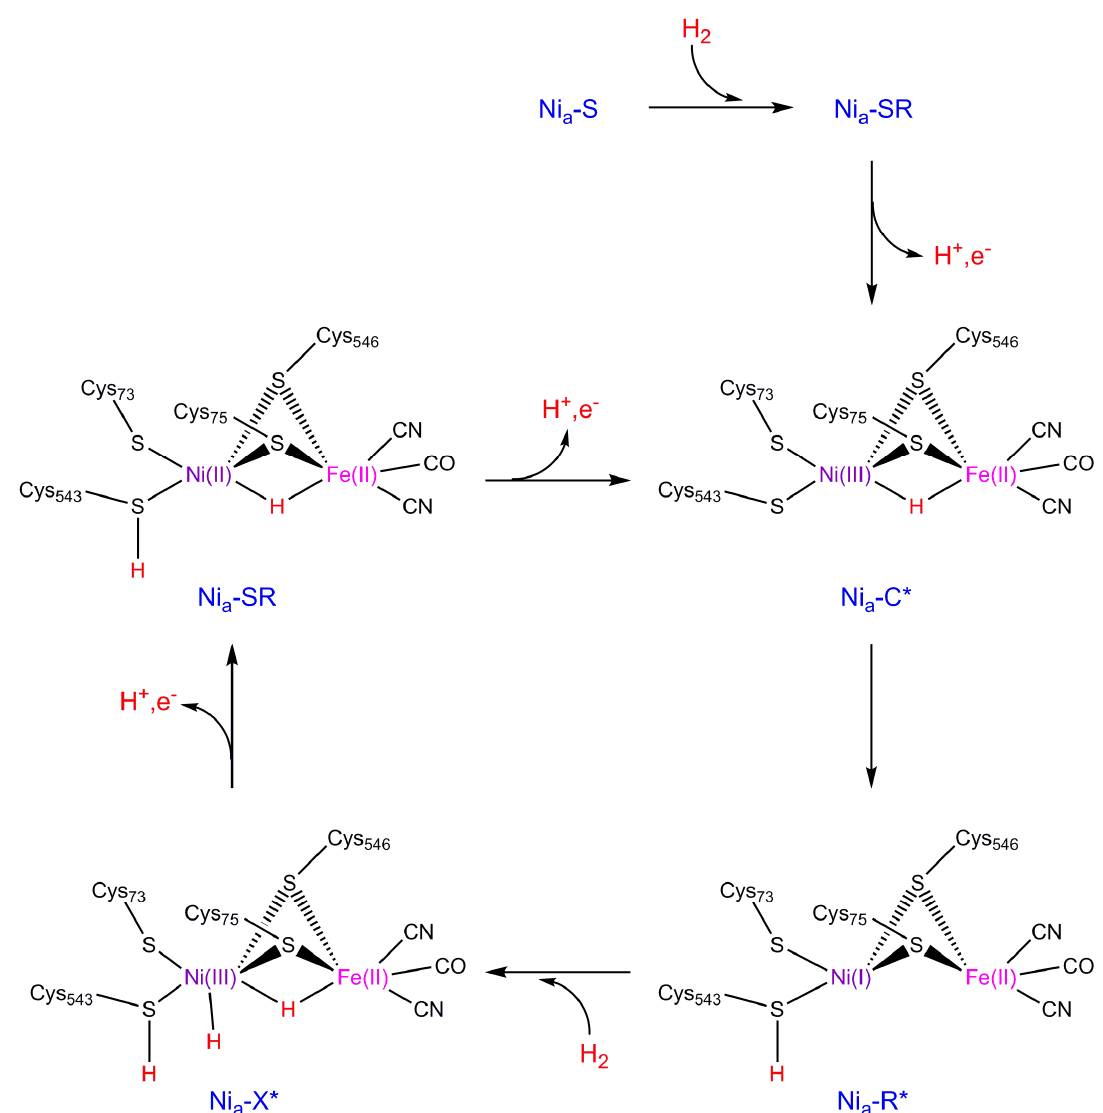
Figure 3. A variant of the mechanism for NiFe-hydrogenases. Adapted from [31], Copyright © 2007, American Chemical Society.